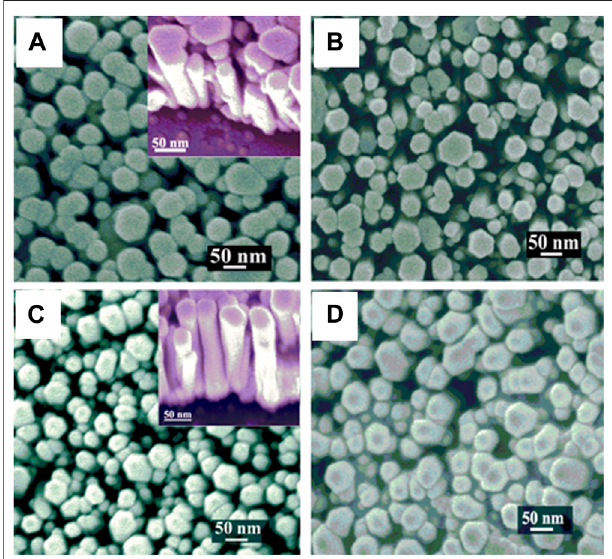
FIGURE 4 | FESEM images of ZnO NRs (A) without excess zinc; (B) 5 mMexcesszinc; (C) 15 mMexcesszinc; (D) 30 mMexcesszinc.Theinsets in (A) and (C) show the tilted view of the growth (Sarkar and Basak, 2011).